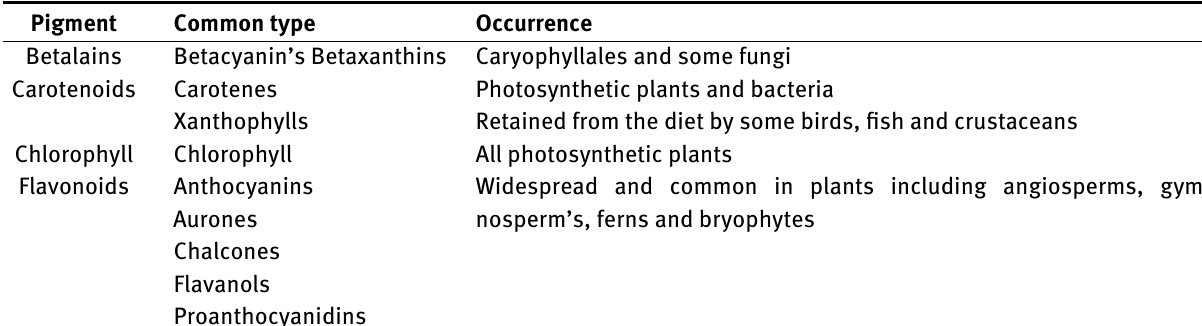
Table 1: Pigments in plants [34] Pigment